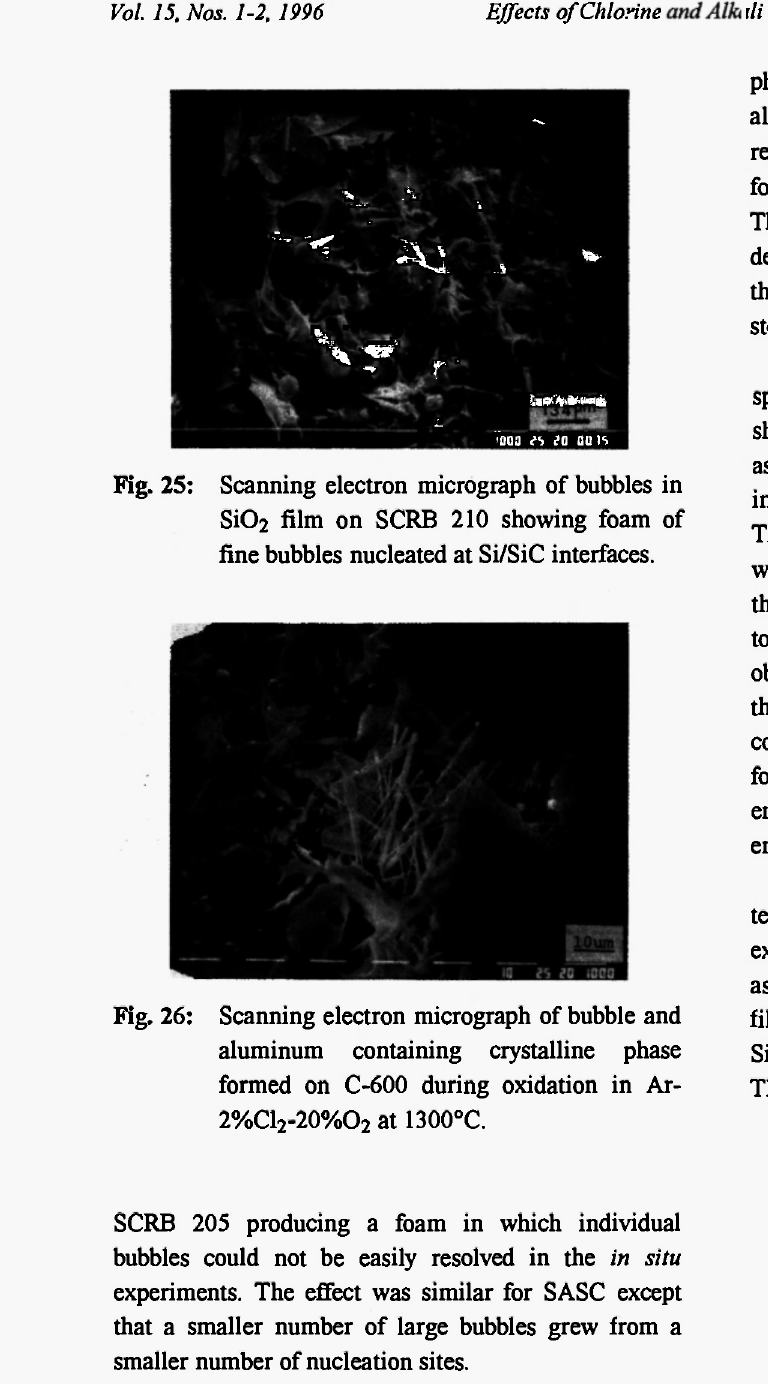
Scanning electron micrograph of bubbles formed on CVD SiC oxidized in Ar-2%C1 20%0 at 2